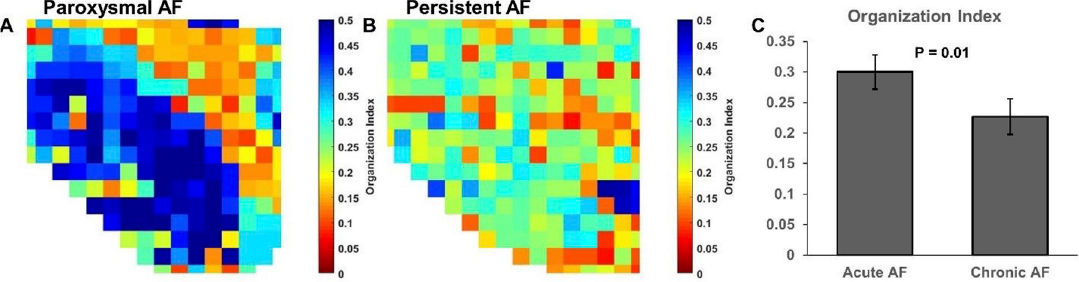
Fig 4. Persistent AF decreases left atrial organizational index. (A-B)Example two- dimensional spatial OI maps for paroxysmal and persistent AF, respectively. There were notable clusters of similar OI that were present in paroxysmal AF (grouped blue and orange areas) that were not present in persistent AF maps. (C) Persistent AF was associated with decreased left atrial OI compared to paroxysmal